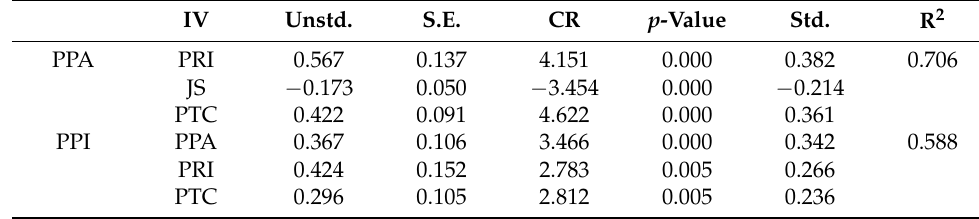
Table 5. Research hypothesis results.